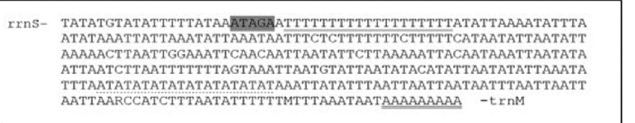
Fig 4. Features presents A+T rich region of Chrysodeixis acuta . The ATAGA motif is shaded, Poly-T strand is underlined, Poly-A stretch is double underlined; the single microsatellite A/T repeat sequence is dotted